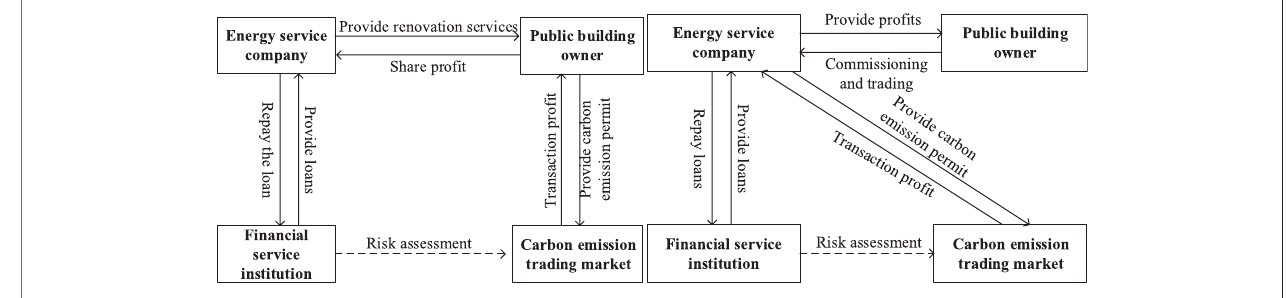
FIGURE 10 | Pattern of dispersing carbon-emission reduction investment and transaction risk of fi nancial institutions and energy service